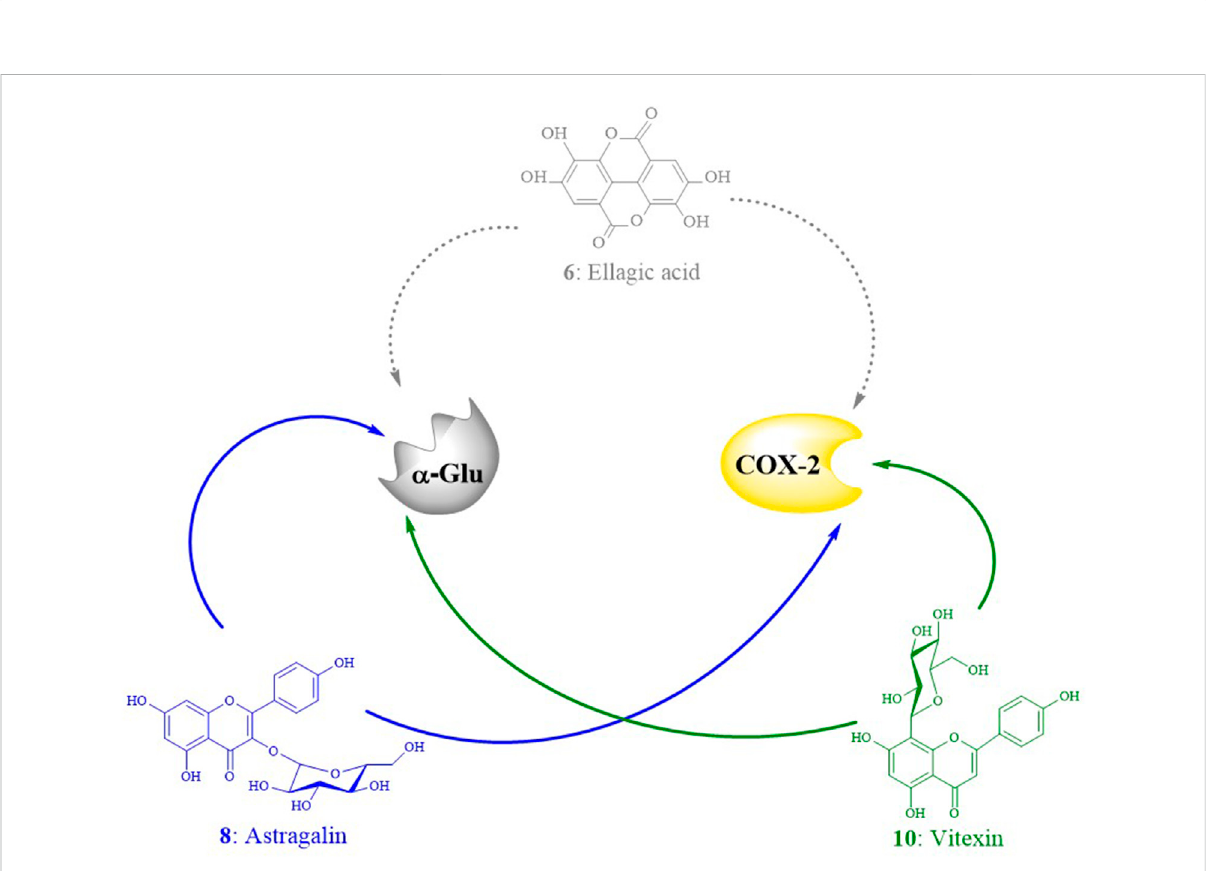
FIGURE 7 Interactionnetworksdiagramoftheligandcandidatesfrom E.humifusa towardtheenzymetargets α -GluandCOX-2.Thedottedarrowsre fl ect weak ligand af fi nities toward the targets active site, whereas the plain ones represent strong af fi